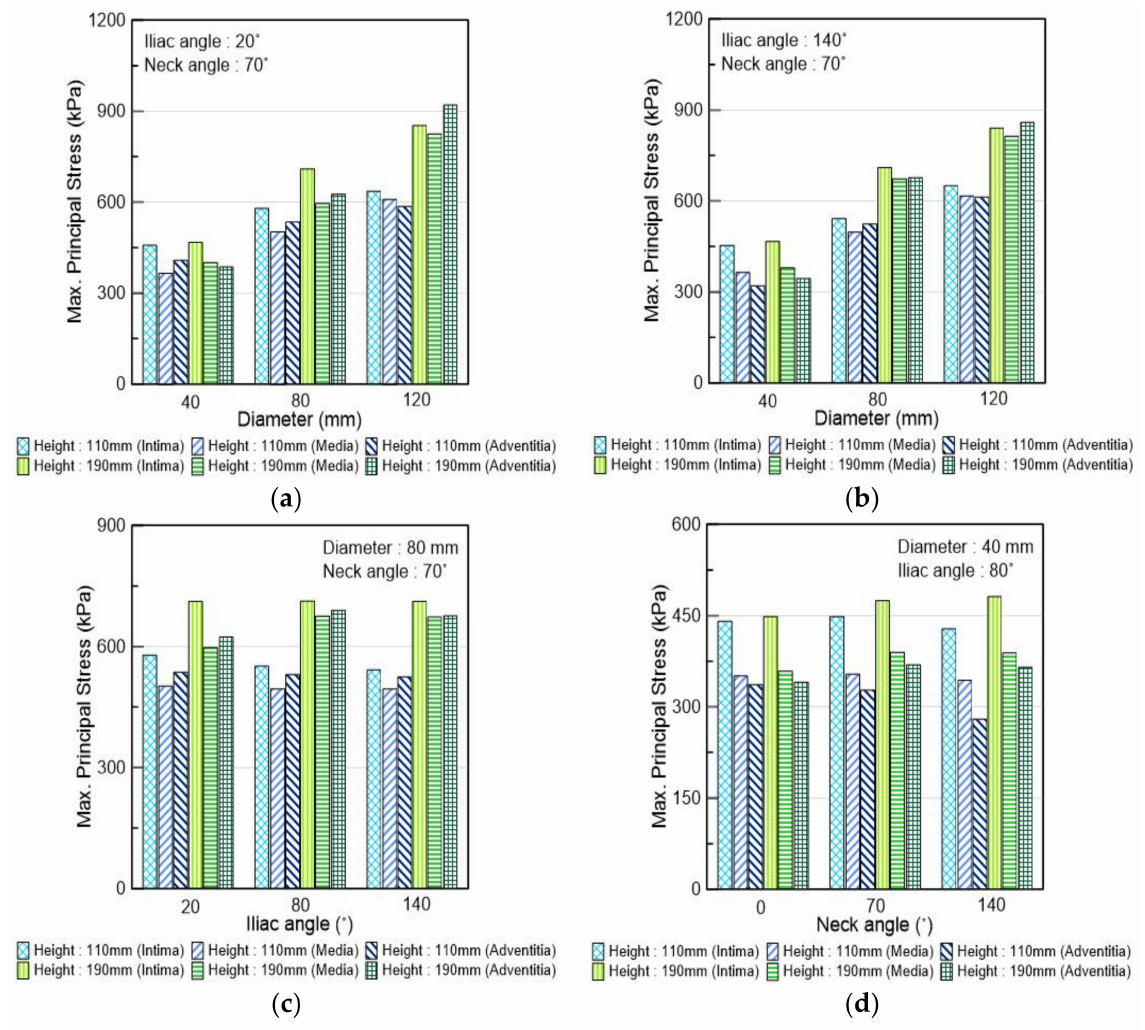
Figure 7. Maximum principal stress according to ( a , b ) diameter; ( c ) iliac angle; and ( d ) neck angle.